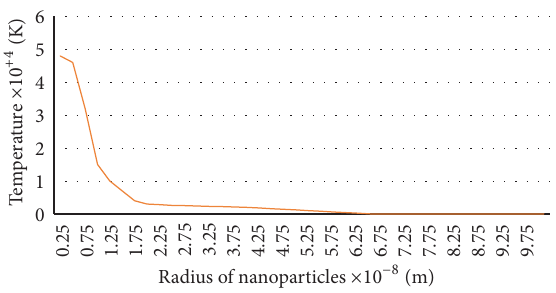
Figure 1: The relation between the temperature and radius for nanoparticles of the laser has the pulse duration 10ns for 740 mJ for silver nanoparticles.